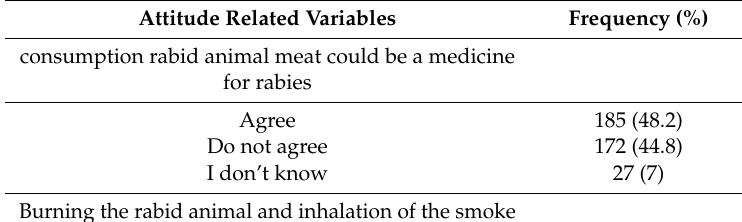
Table 5. Attitude of the study participants towards rabies (N = 384),